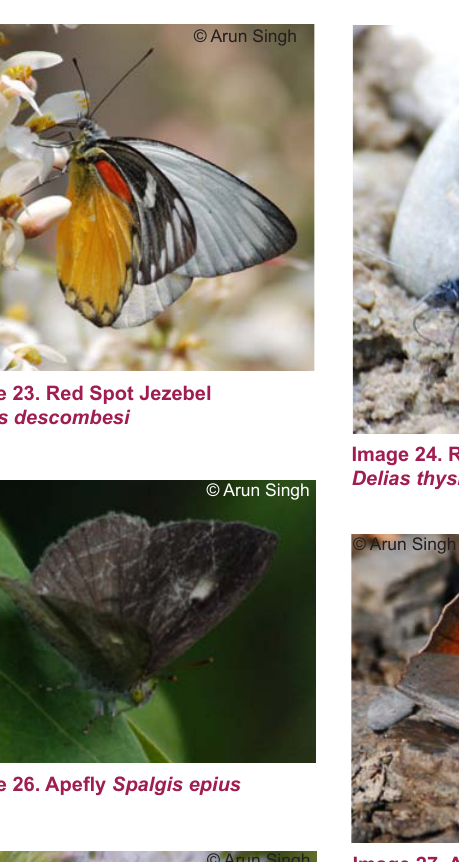
Image 27. Angled Sumbeam Curetis acuta